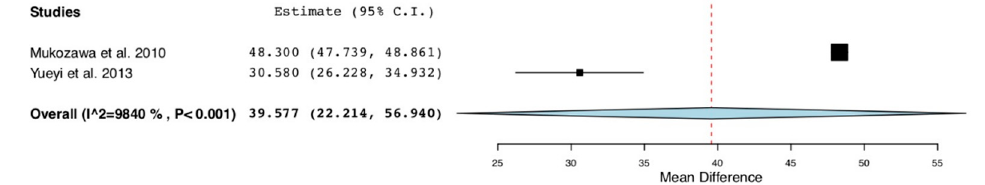
Figure 4. Forest plot: studies evaluating the percentage of bone formation at 4-6 weeks after the local application of statins in the treatment group versus no introduction of filling material or the introduction of polylactic acid in the control group.